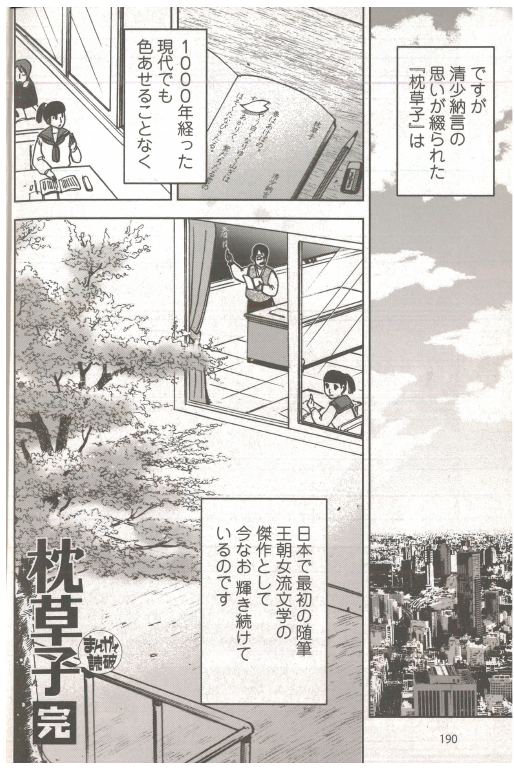
Figure 5. A teacher introduces Sei Shōnagon’s Makura no sōshi in a classroom setting. Variety Art Works, Makura no sōshi , Manga de dokuha (2011), 190. (Courtesy of Īsuto